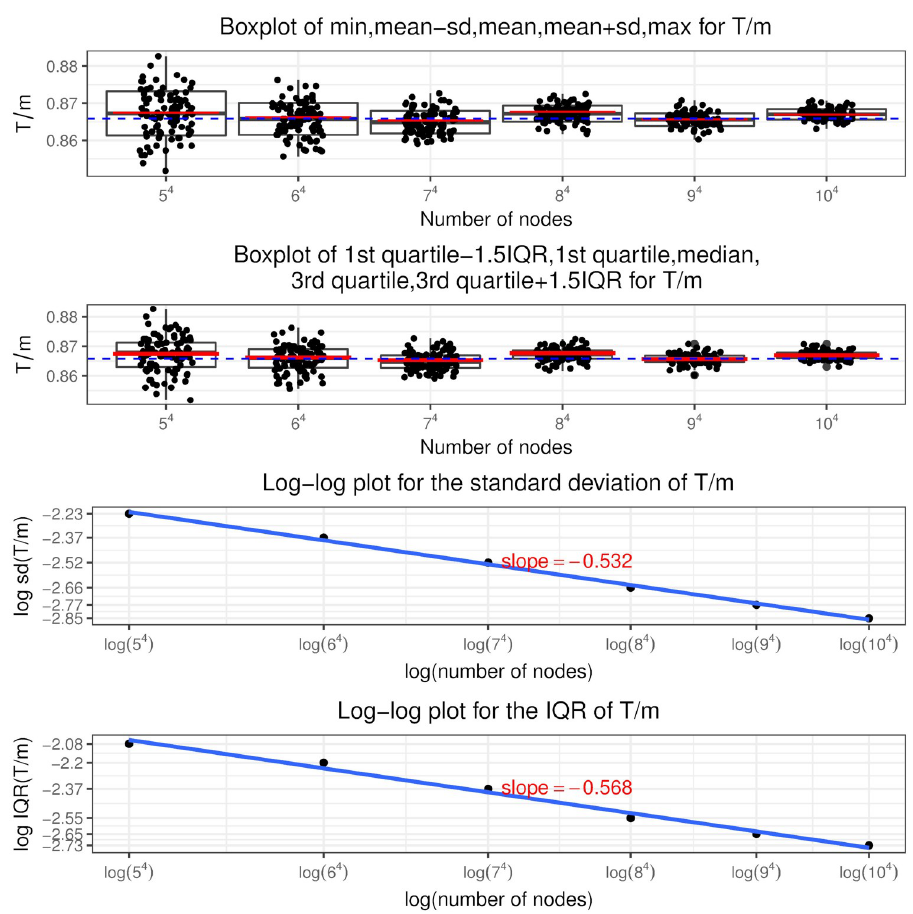
Fig 11. The boxplot and log-log plot of standard deviation and IQR for T / m under alternative policy.